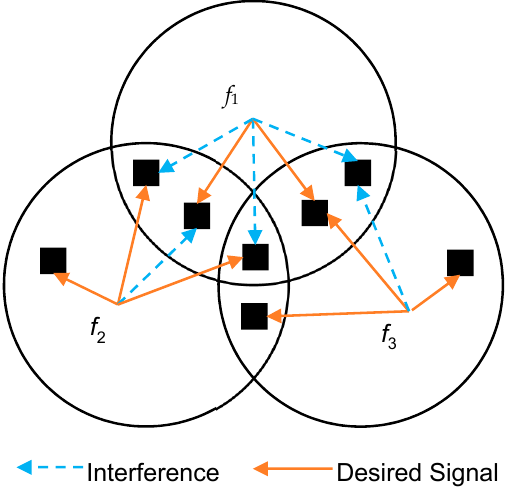
Figure 1. A scenario of a cell switching off.